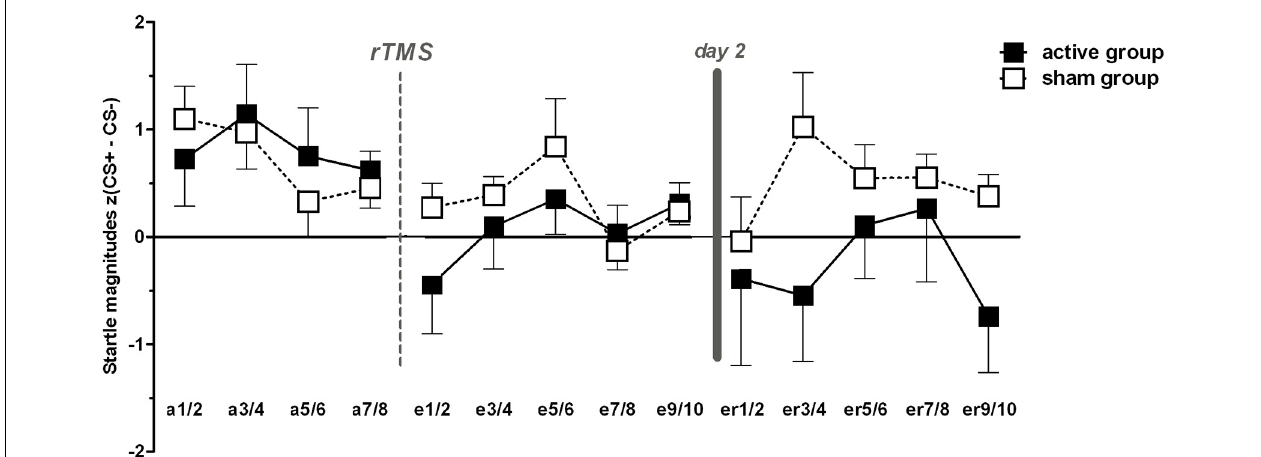
FIGURE 3 | Conditioned responses ( CS + minus CS − ) indexed by fear potentiated startle magnitudes for acquisition (a), extinction (e), and extinction recall (er). For reasons of clarity two trials were averaged for each